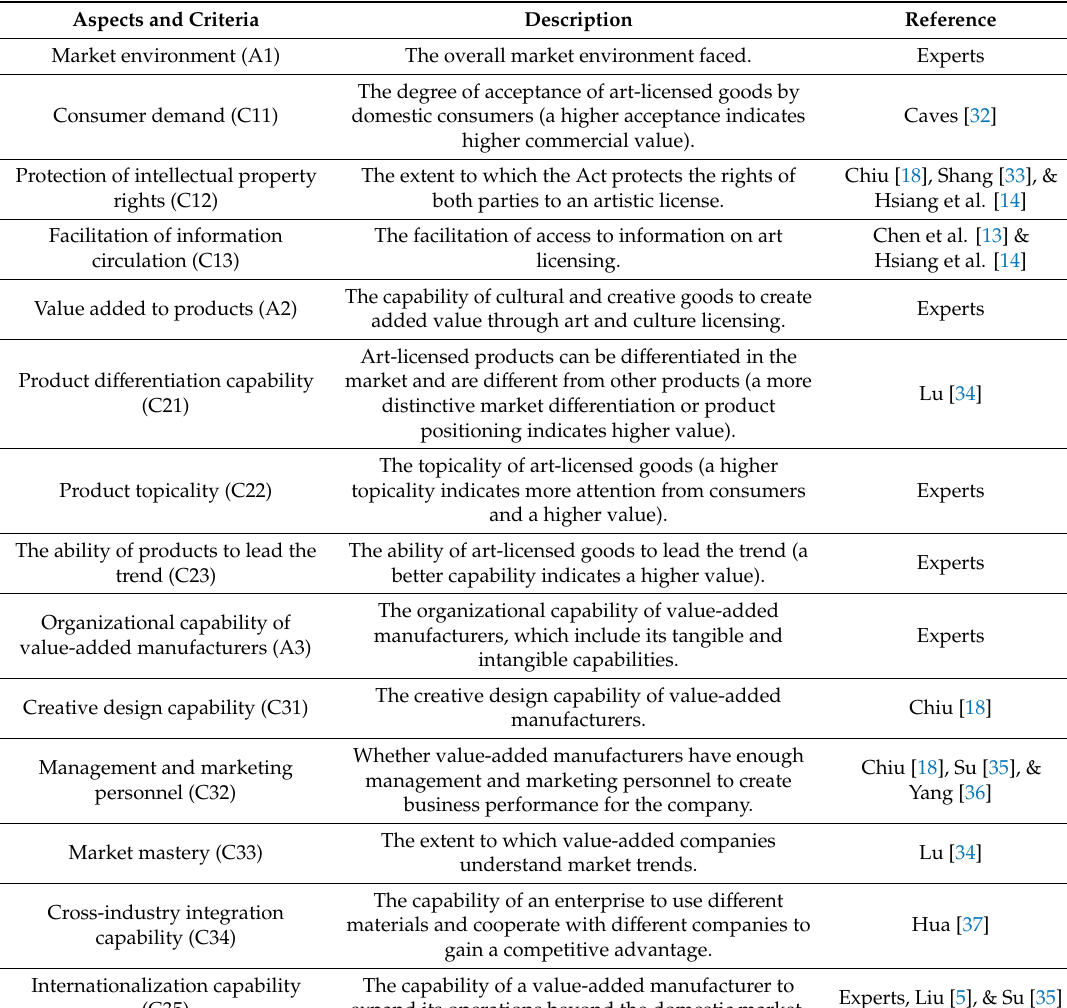
Table 3. Definitions of aspects and